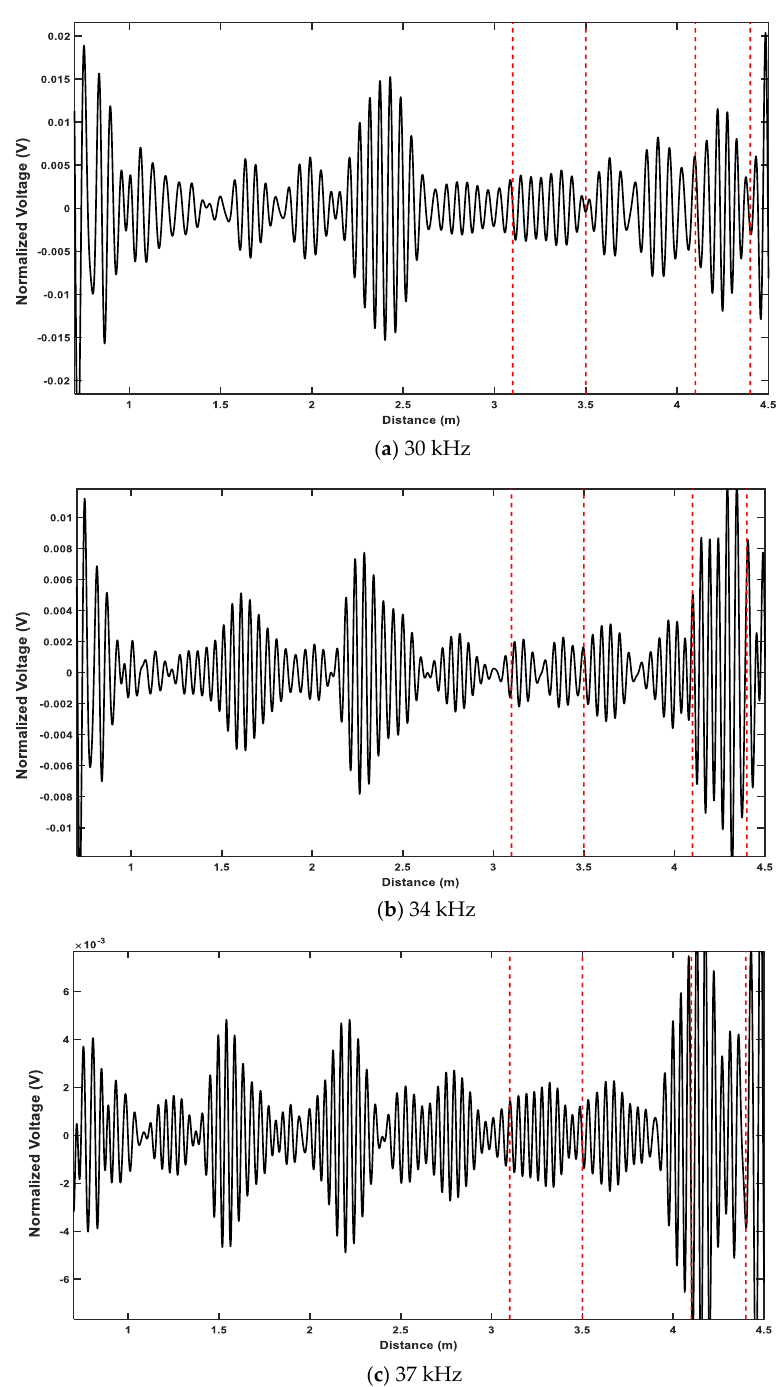
Figure 5. Baseline signals of pipe with no defect with frequencies of ( a ) 30 kHz; ( b ) 34 kHz; and ( c ) 37 kHz. The first marked region (3–3.5 m) is the location of the first defect, and the second marked region (4.1–4.5) is the location of the second defect.